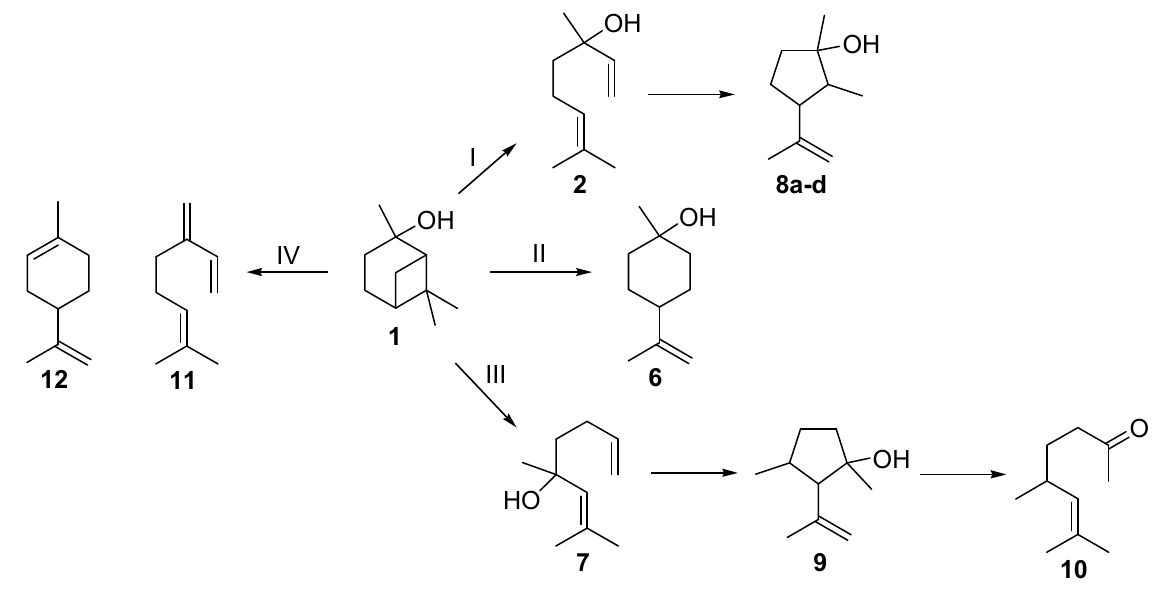
Scheme 2. Simplified reaction scheme for the isomerization of pinan-2-ol ( 1